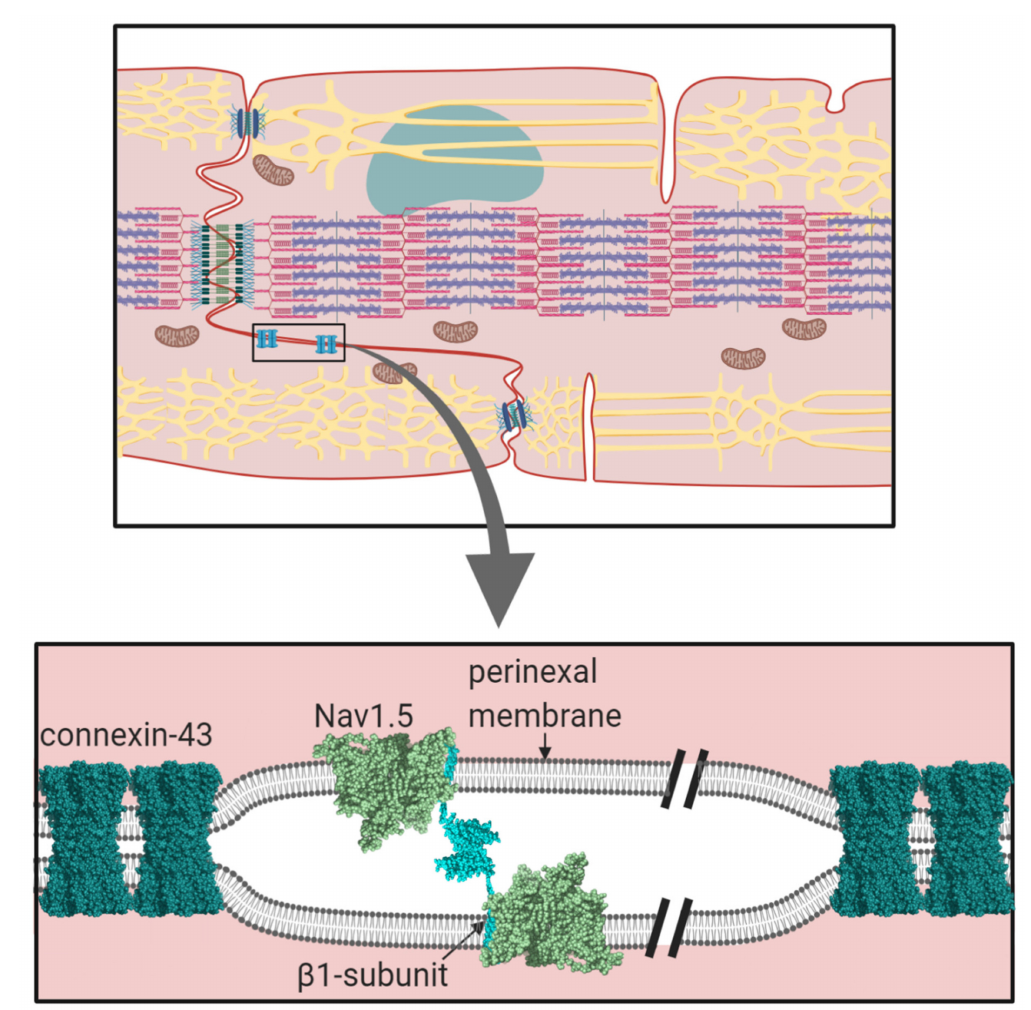
Figure 6. The proposed role for the β 1-subunits in stabilising Nav1.5 channels on both apposing perinexal membranes, whilst also maintaining the necessary width between perinexal membranes to ensure e ffi cient ephaptic